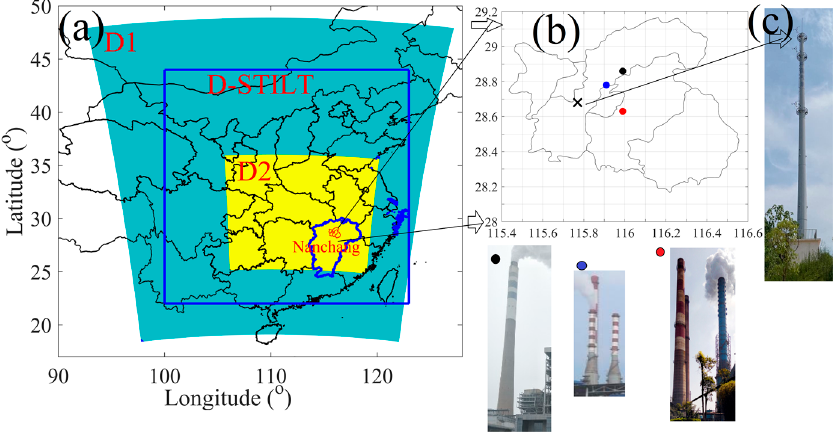
Figure 1. ( a ) WRF-STILT model setup, ( b ) the location of tower site and three power industry related “super” emitters by coal combustion, and ( c ) tall tower, note the boundary of Nanchang city is displayed in red line in panel a, the symbol “×” in panel b represents tower site, and three dots in different colors are “super emitters” with photos also displayed below.